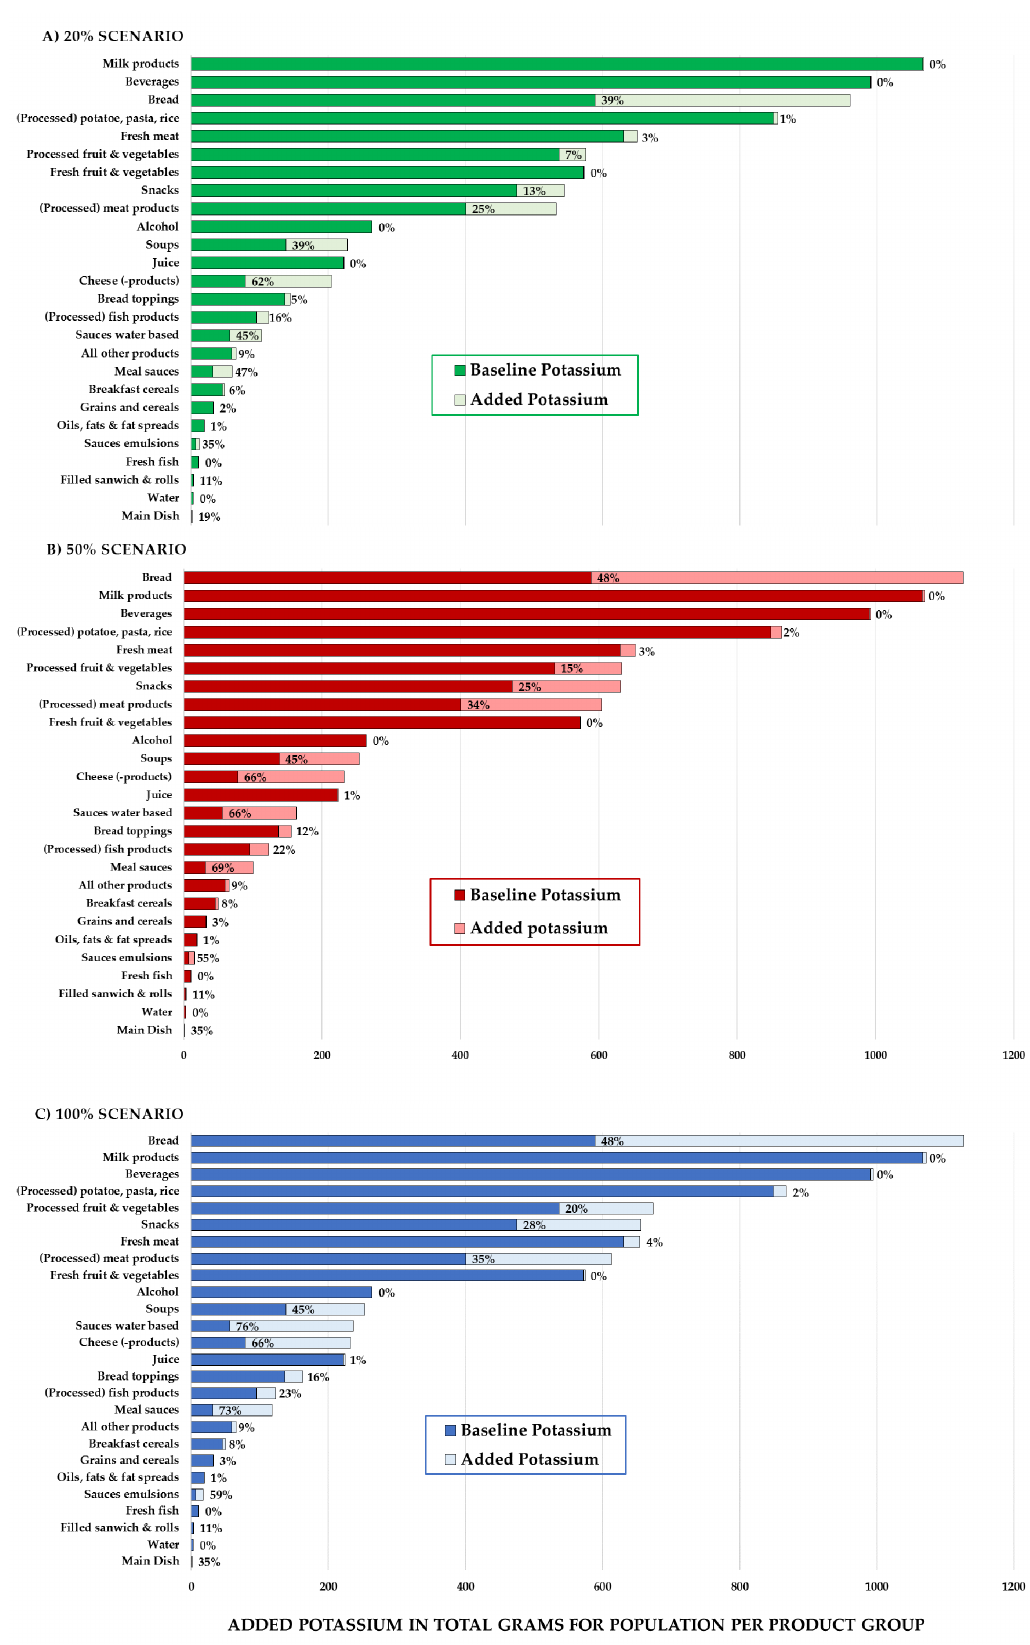
Figure 4. Level of potassium per food group shown at baseline (dark bar) plus the amount added during reformulation (light bar) for all three replacement scenarios ( n = 2106).